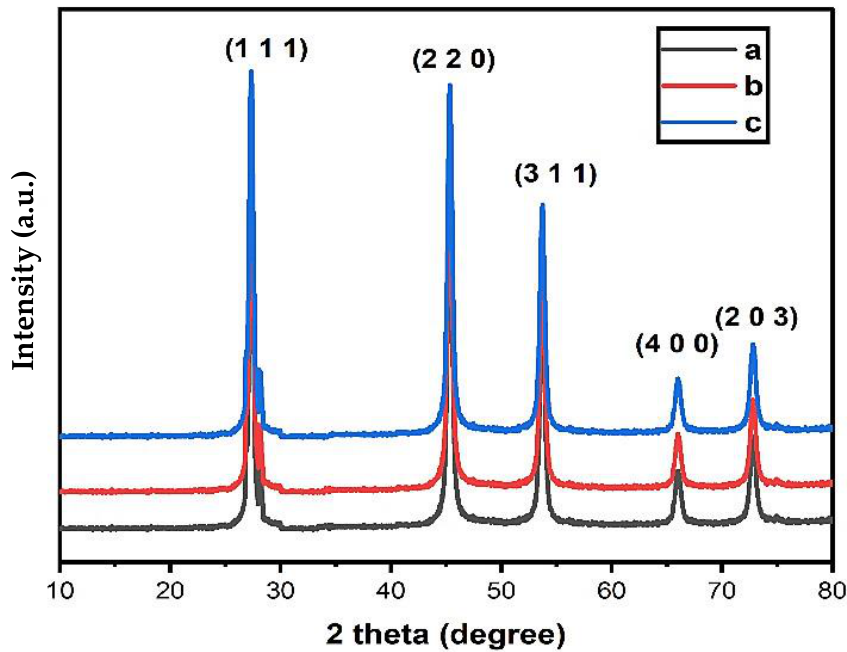
Figure 2. X-ray diffraction patterns of Sr (0.01 ( a ), 0.05 ( b ), and 0.1 ( c ))-doped ZnSe